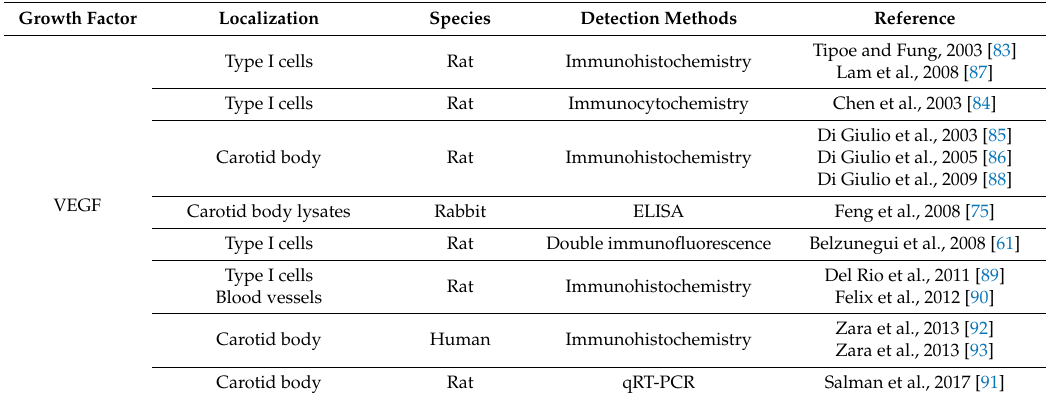
Table 10. Vascular growth factor. Expression of VEGF in the carotid